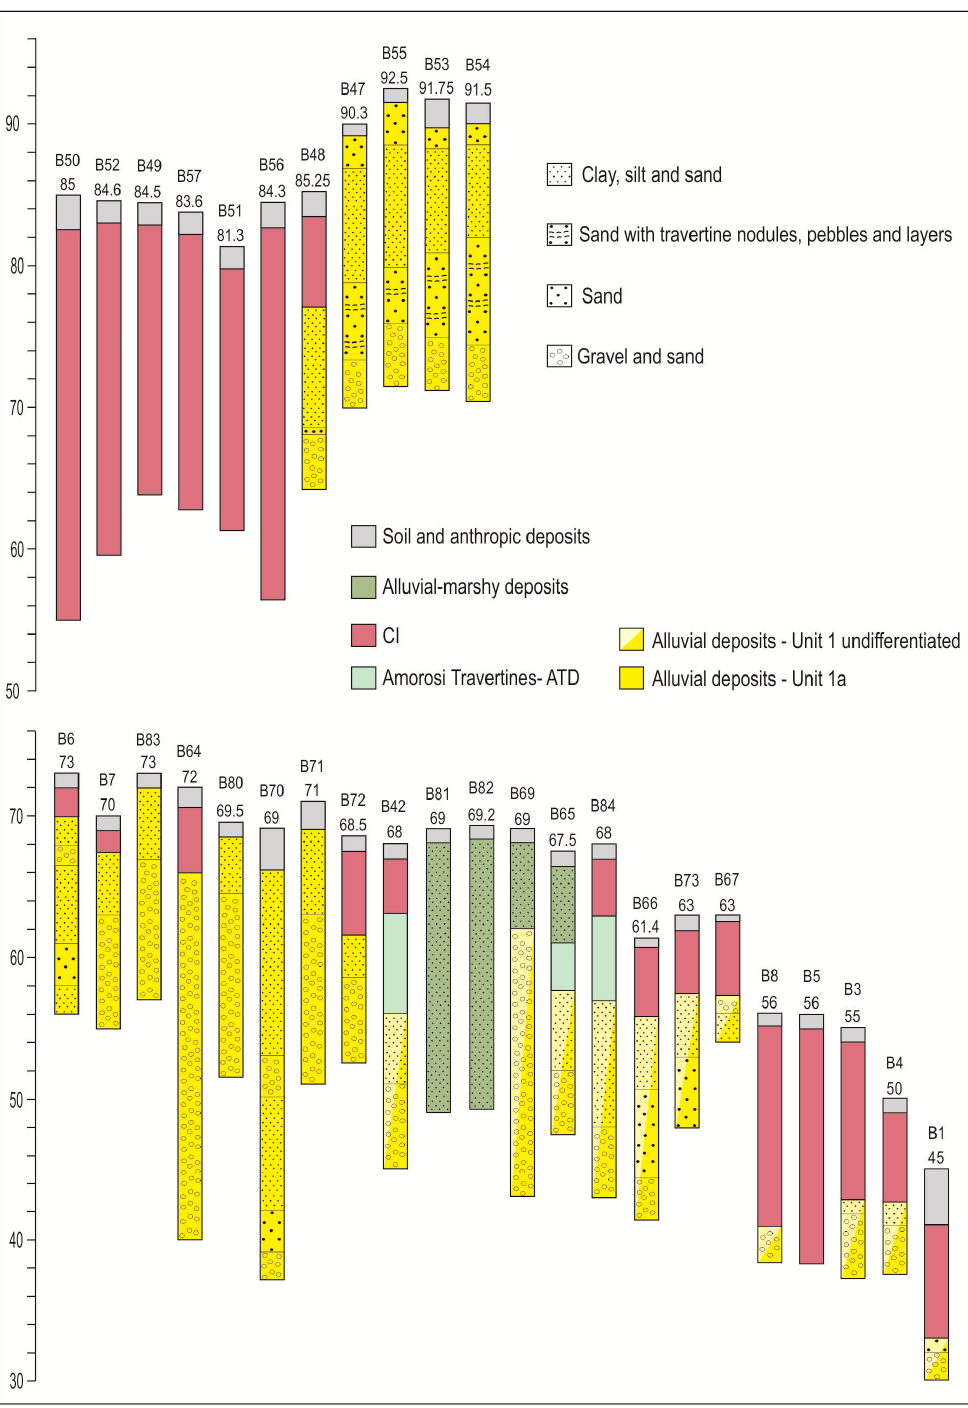
Figure 11. Stratigraphic logs of boreholes drilled in the Telese Plain area on the CI and HFT terraces. For location of boreholes, see Figure 9.